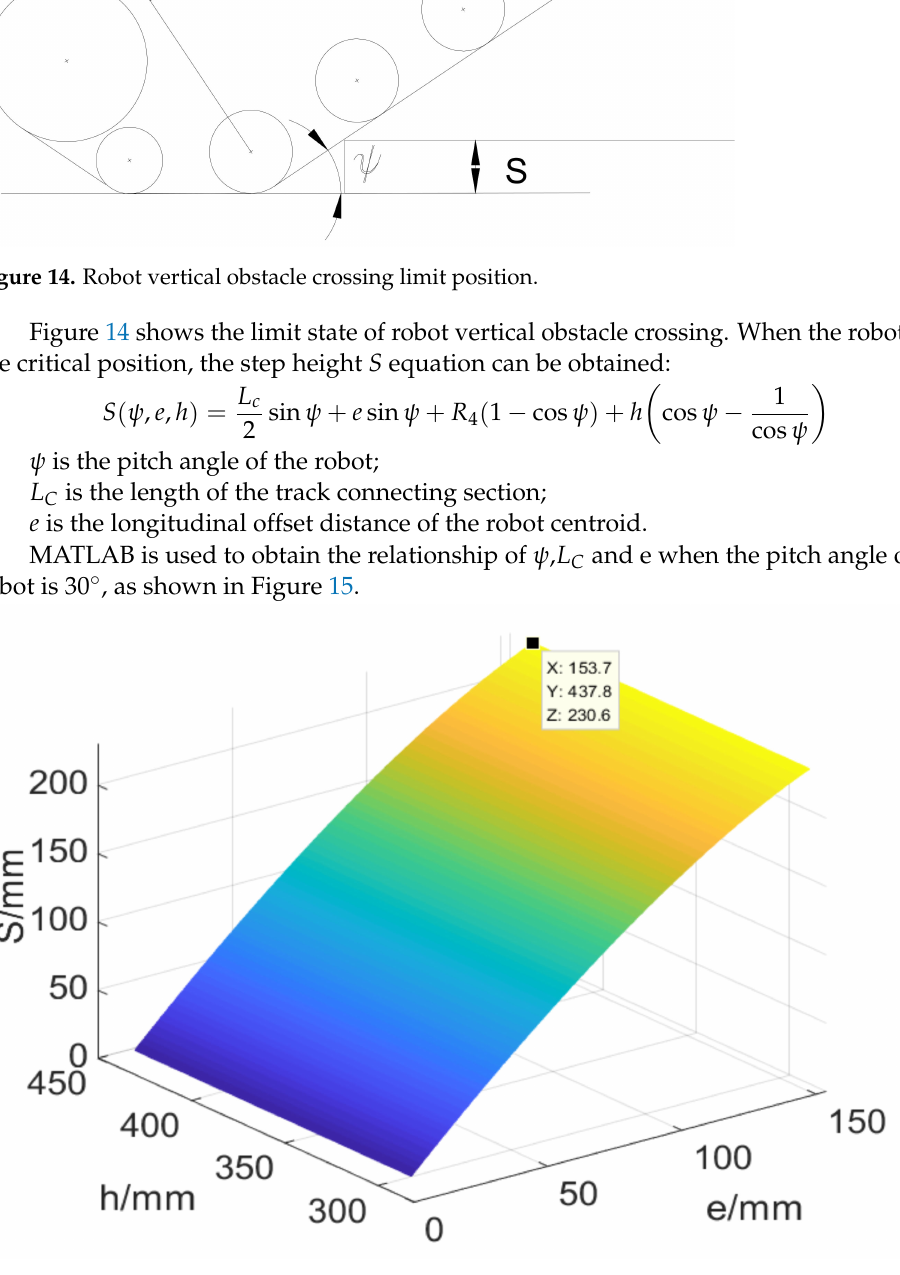
Figure 15. Relationship between obstacle crossing limit height and longitudinal position of